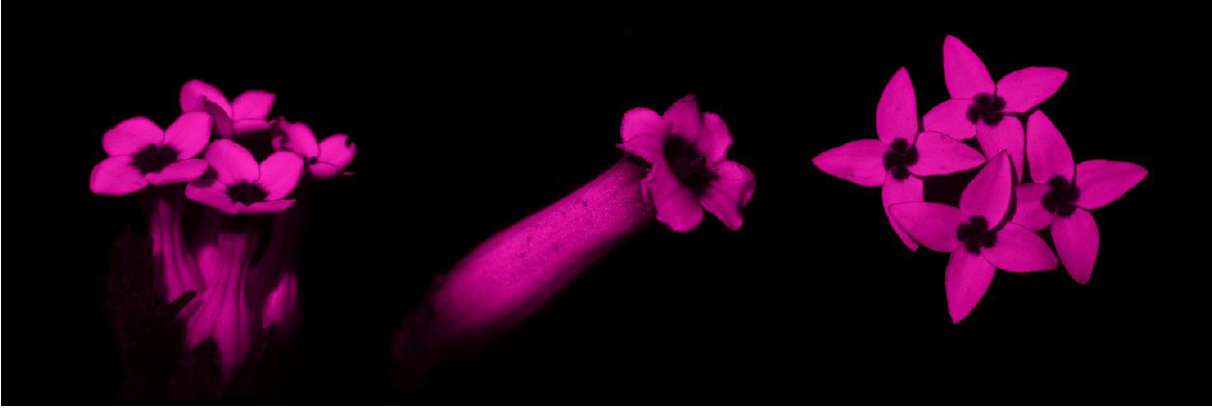
Figure 2. Long-proboscid fly-pollinated species Erica ampullacea , Erica aristata and Erica fastigiata coventryi (left to right) with ultraviolet reflectance (violet areas). Photos taken by S McCarren with a UV-sensitive